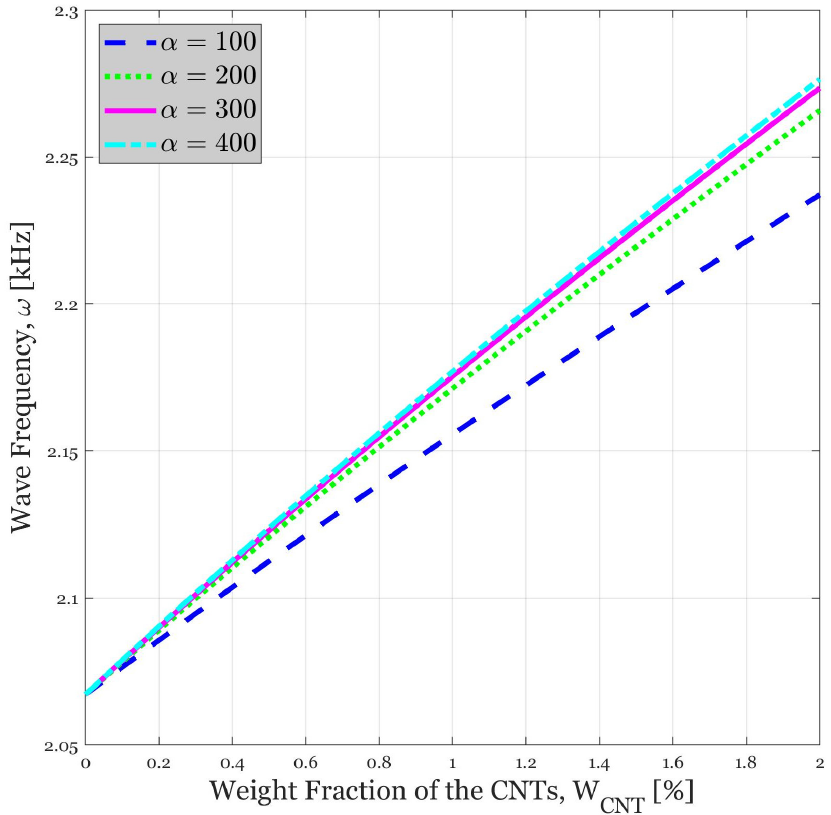
Figure 6. Variation in the wave frequency versus weight fraction of the CNTs for various CNTs’ length-to-diameter ratio. In this diagram, [0, 90, –90, 0] s lay-up is used (V f = 0.2, β = 2).